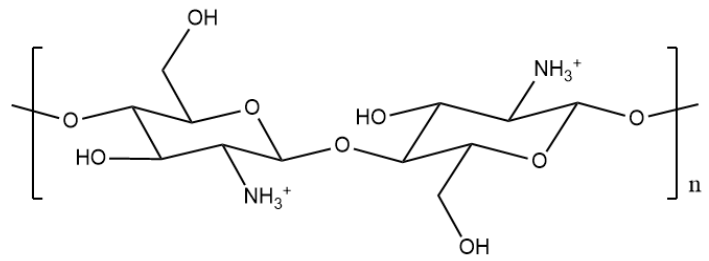
Figure 2. Structure of pristine chitosan.